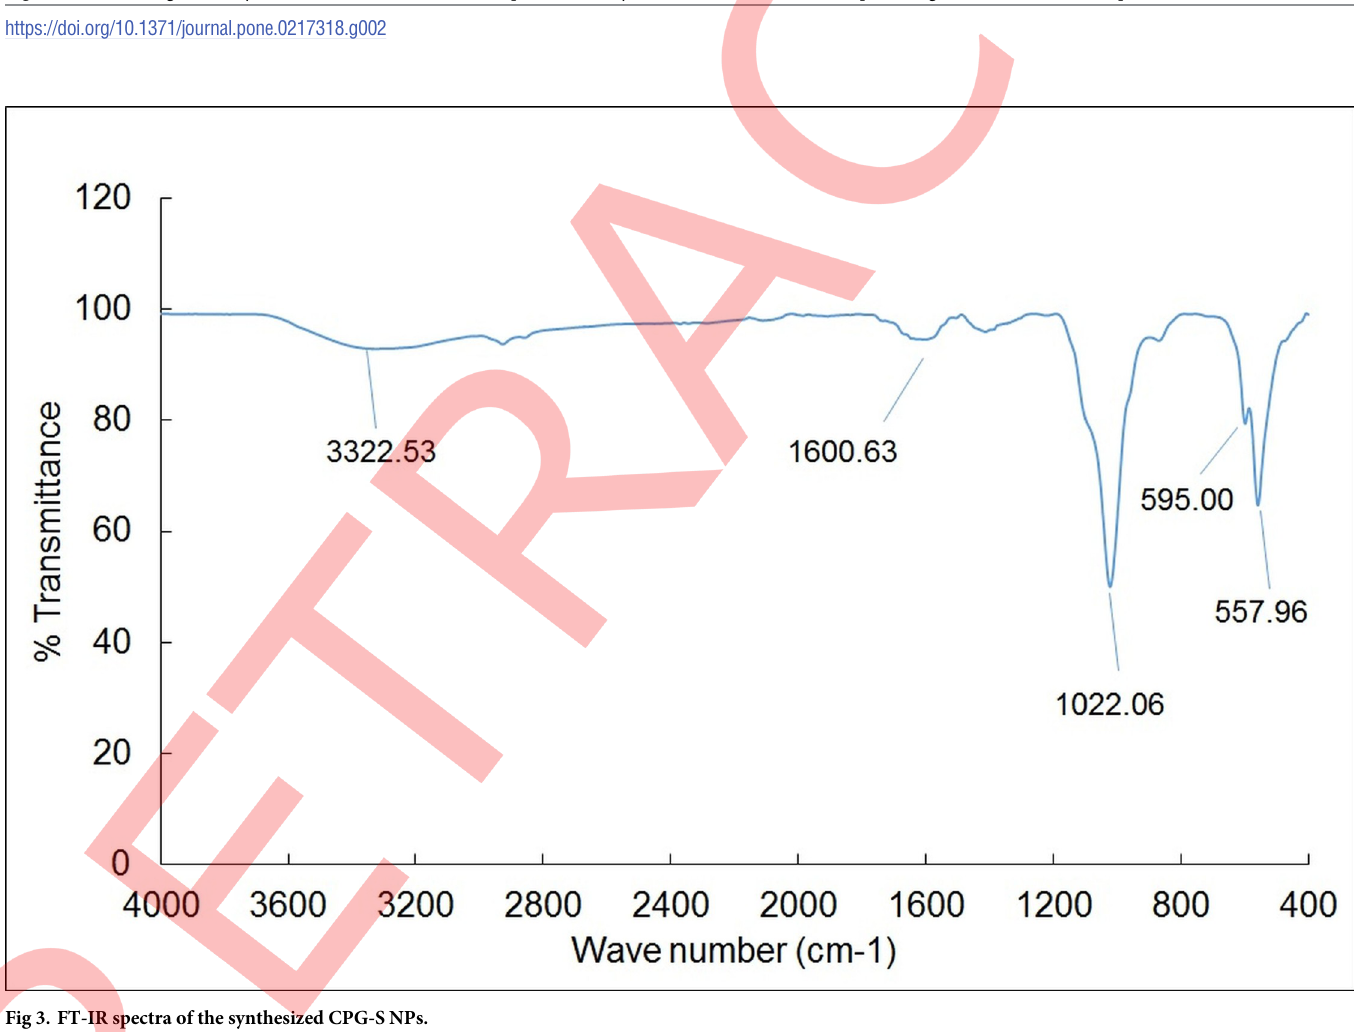
Fig 3. FT-IR spectra of the synthesized CPG-S